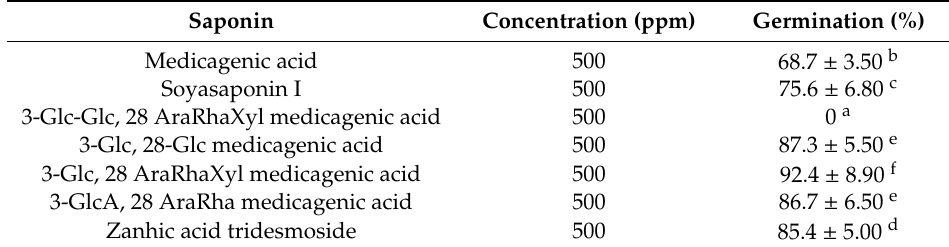
Figure 7. Structures of saponins identified in leaf extracts of alfalfa. Table 6. Identification of saponins in the alfalfa leaf